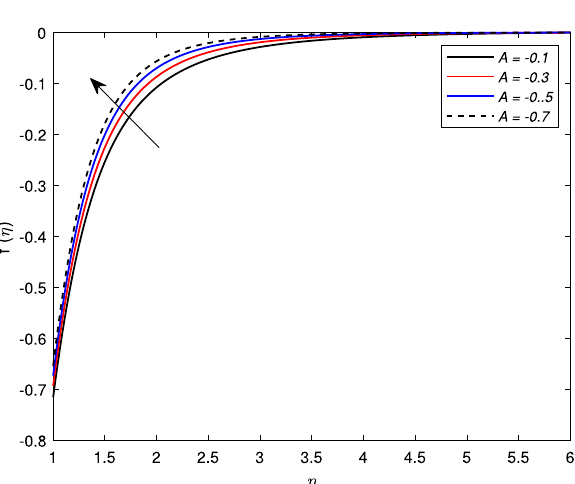
0.2 (contracting cylinder). = −